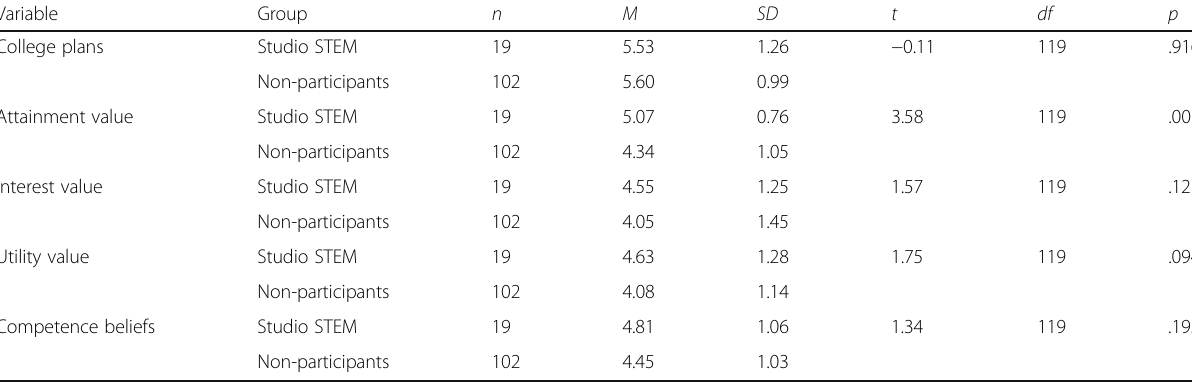
Table 3 Comparing Studio STEM participants and non-participants before program implementation Variable Group College plans